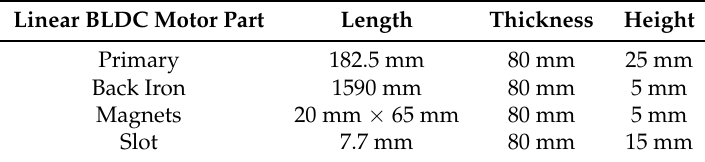
Table 2. Fundamental parameters of designed linear BLDC